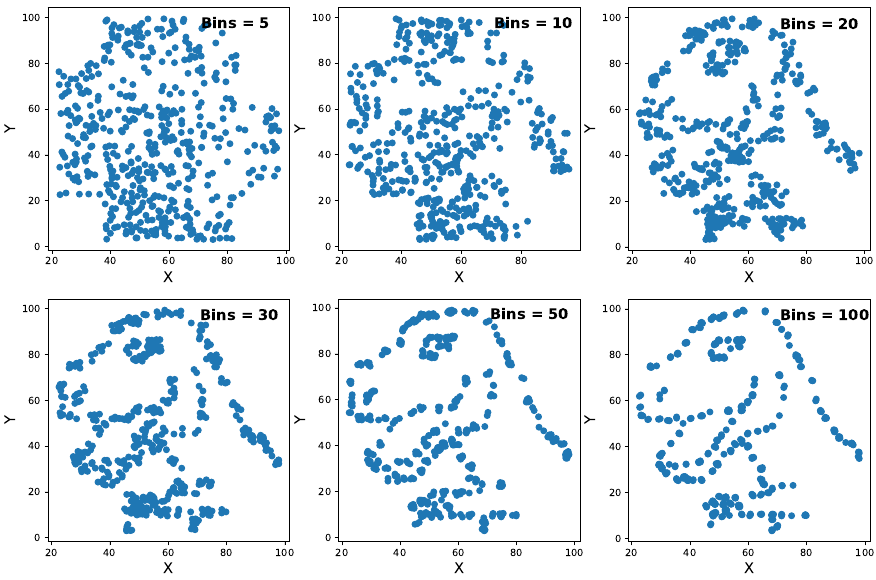
Figure 7. Evolution of the synthetic data for different numbers of partitions or bins.